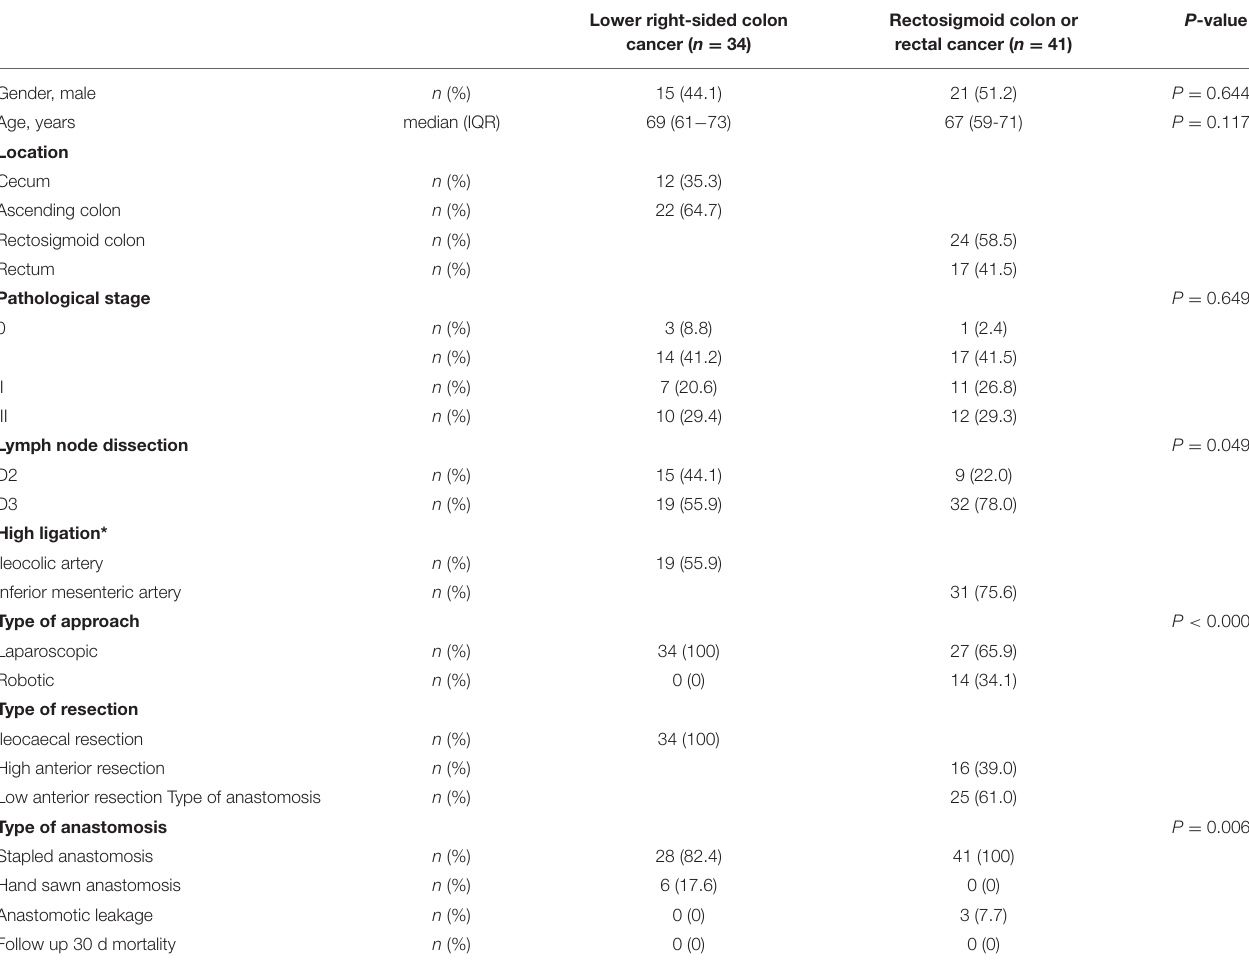
TABLE 1 | Demographic details and clinical characteristics of patients with lower right-sided colon cancer and patients with rectosigmoid colon or rectal cancer.